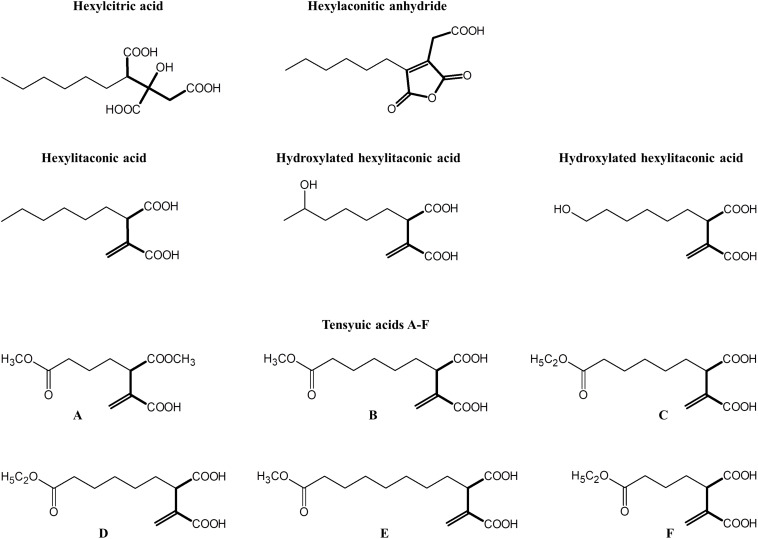
Structures of alkylcitric acids previously isolated from A. niger (Widenmuller et al., 1972; Almassi et al., 1994; Mondal et al., 2000; Hasegawa et al., 2007; Li et al., 2011). All these compounds show two common moieties: a saturated hydrocarbon “tail” (thin bonds) and a citrate-derived “head” (thick bonds).